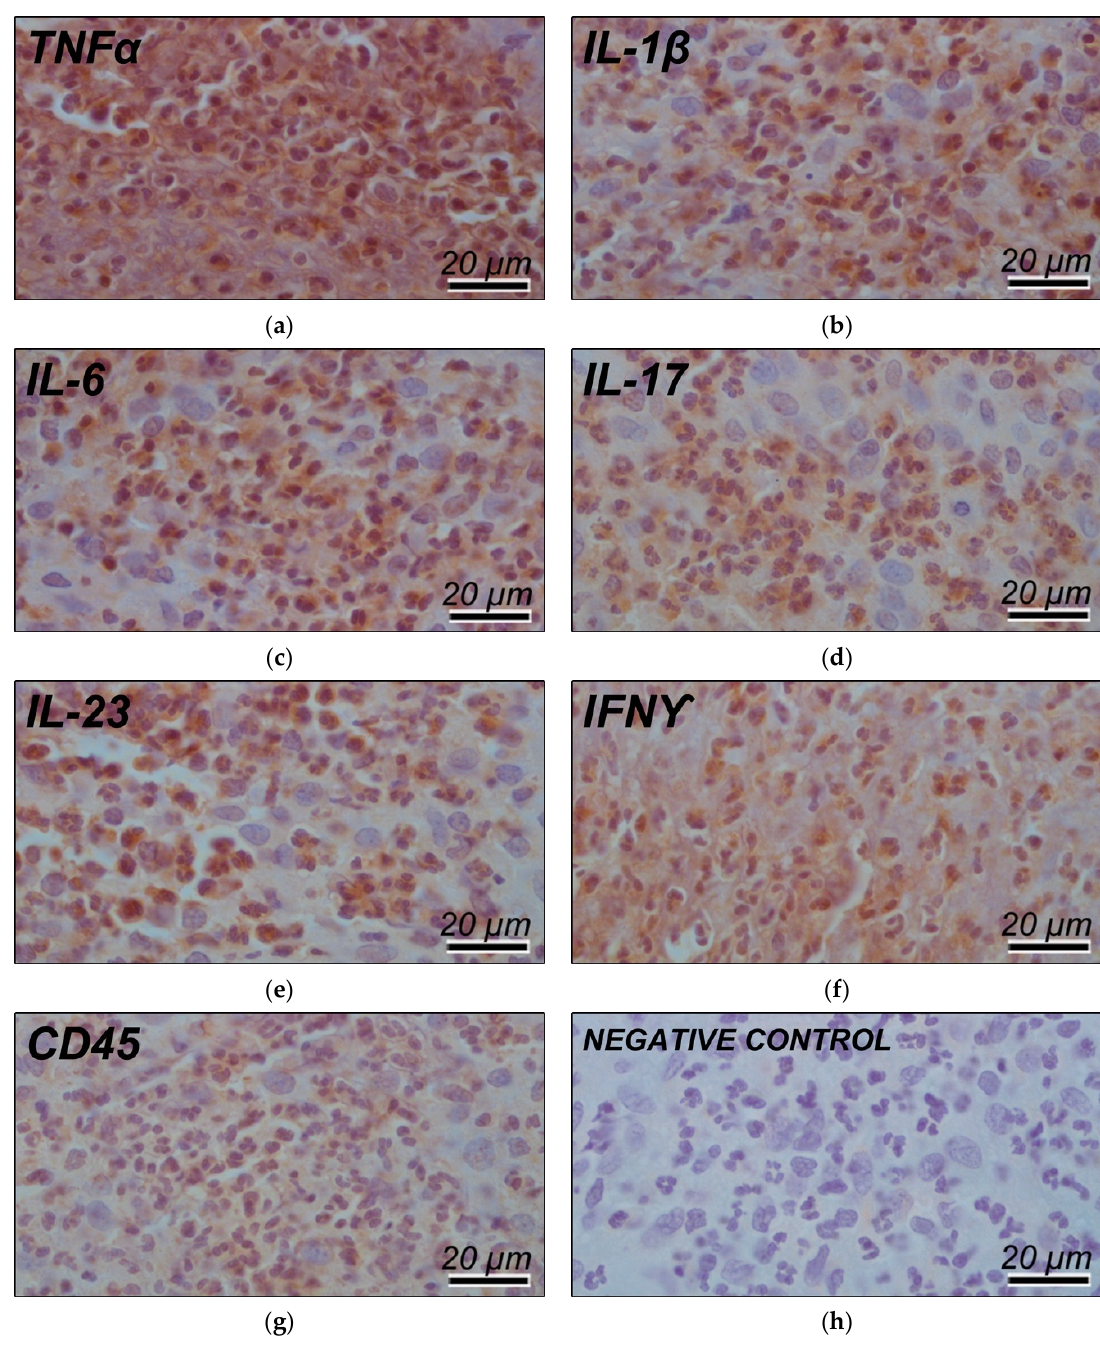
Figure 4. Immunohistochemical panel of ( a ) TNF α , ( b ) IL1, ( c ) IL6, ( d ) IL17, ( e ) IL23, ( f ) IFN γ , ( g ) CD45 proteins, and ( h ) negative control, showing intense areas of allergic response labelling. Magnification 100×, staining: Harris’s hematoxylin.